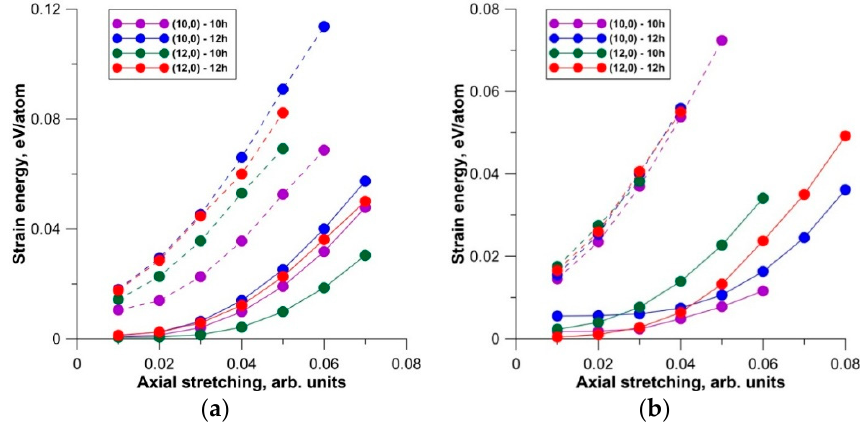
Figure 6. Dependence of the strain energy on the magnitude of the stretching of graphene–CNT composite films: ( a ) a monolayer; ( b ) a bilayer. Solid lines correspond to the case of stretching perpendicular to CNTs ( X -axis), while dotted lines represent stretching along the CNT axis ( Y -axis).